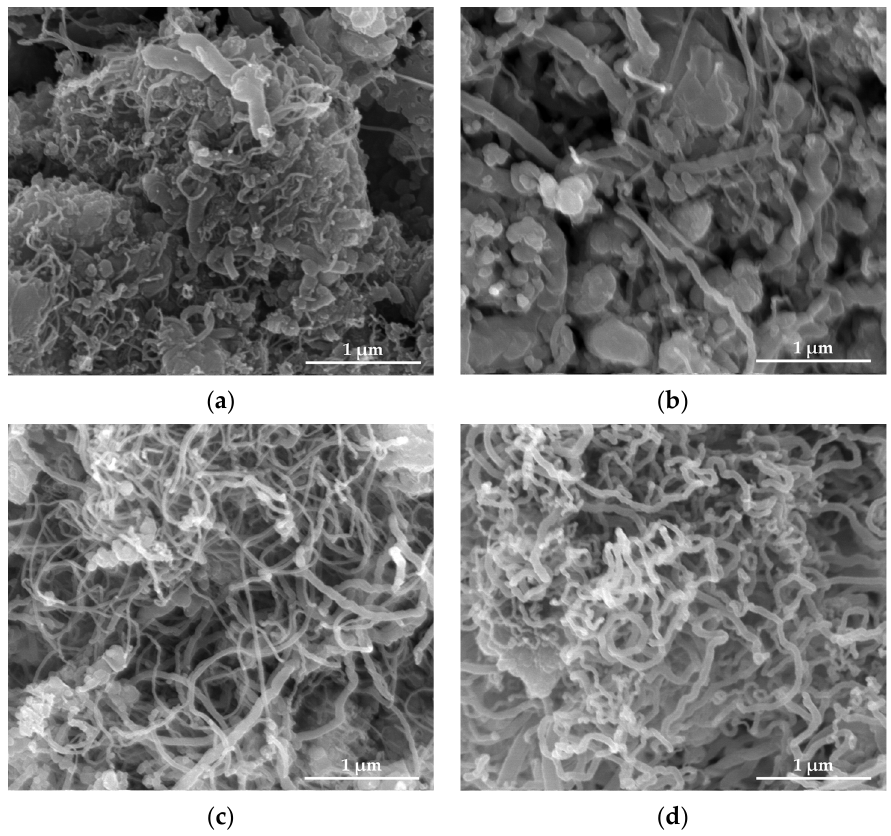
Figure 3. SEM images of CNTs synthesized at 15 ( a ); 30 ( b ); 45 ( c ); 60 min ( d ).